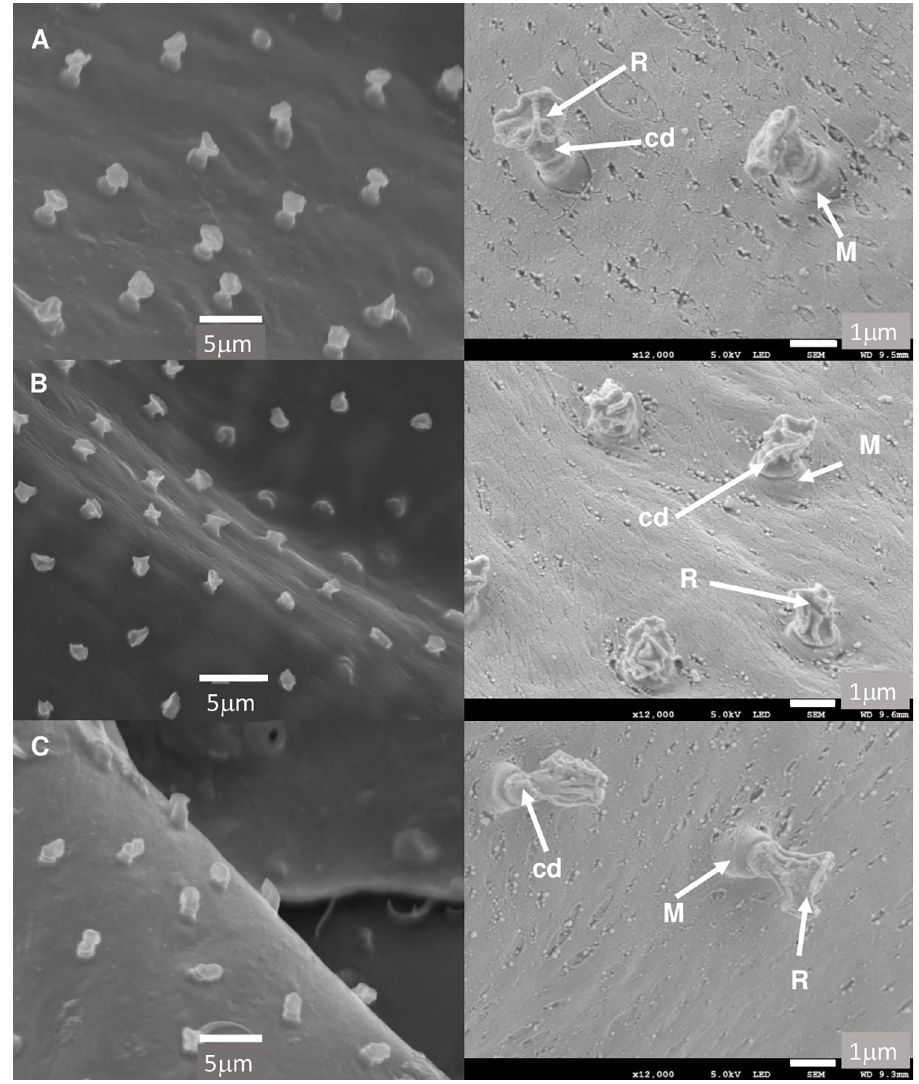
Fig 3. SEM images of the inner cuticle surface of the abdominal tergites of 3 members of the Lu . longipalpis s.l. species complex showing the cuticular elements; manifold, reservoir and cuticular duct, of the secretory apparatus. Secretory apparatus observed by SEM after KOH digestion of Lu . longipalpis abdominal tergites from; A) Campo Grande, B) Sobral and C) Jacobina. The Manifold (M), Reservoir (R) and cuticular duct (cd) are indicated in the enlarged images on the right of the figure. Images on the left side (x3,500 magnification) were taken on a Jeol JSM- 5600. Images on the right (x12,000 magnification) were taken on a Jeol JSM-7800F.